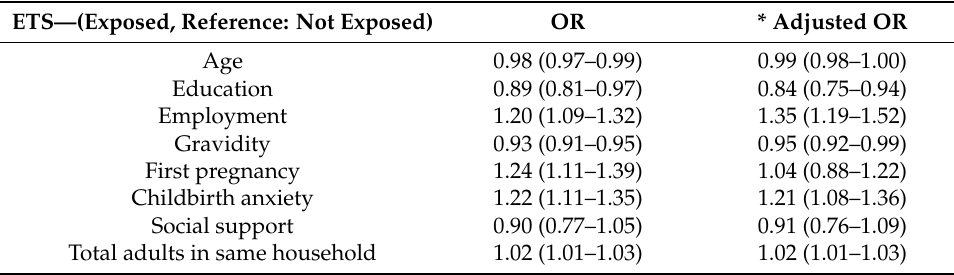
Table 2. Crude and multivariate regression model results on the associations between socio- demographic and pregnancy-related factors and self-reported exposure to ETS in pregnant women in Al Ain, UAE. The Mutaba’ah